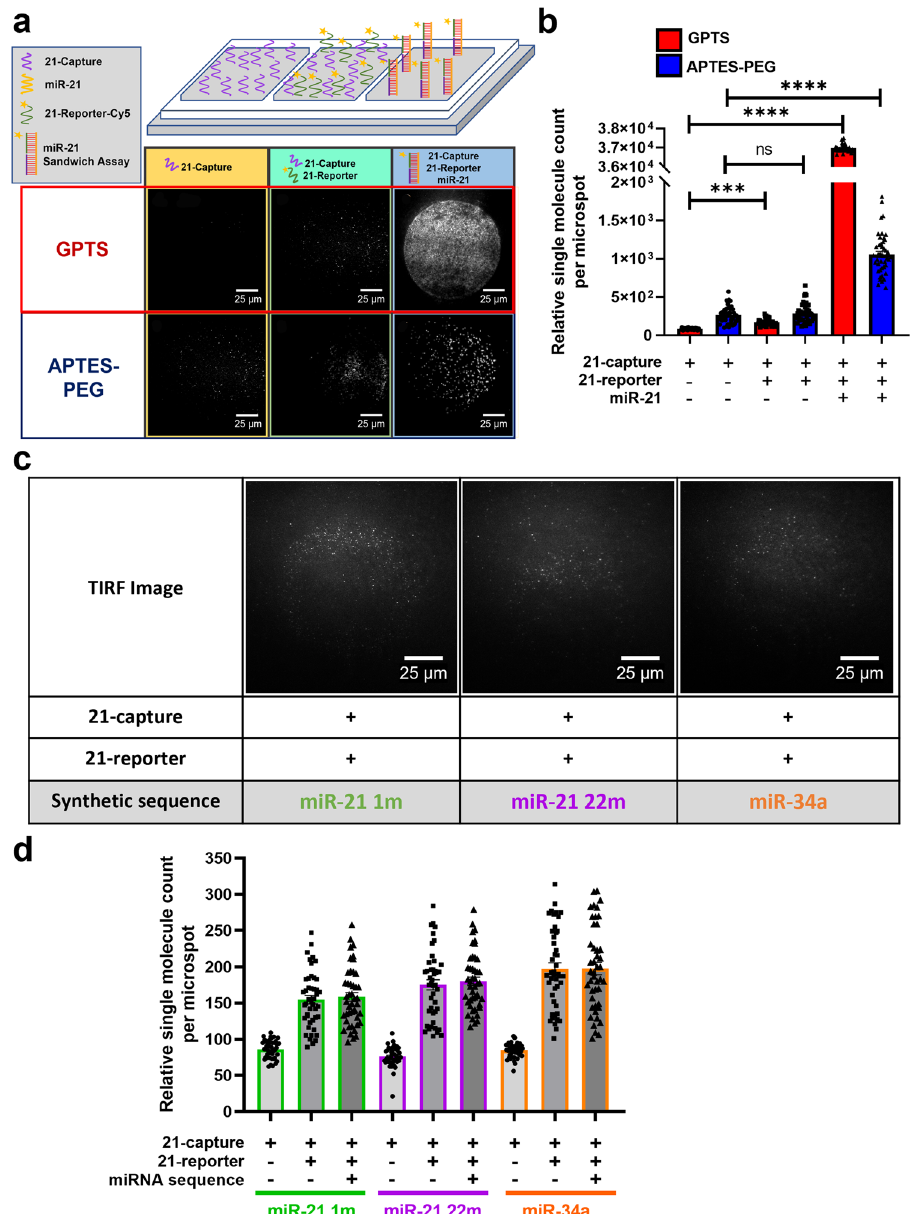
Fig. 1 MiR-21 assay development. a Schematic diagram of an open chip platform consisting of three wells comparing GPTS (Red) and APTES-PEG (Blue) passivated surfaces: fi rst well with 21-capture probe, second well with 21-capture and 21-reporter probes, and third well containing 1.2 ×10 6 molecules/nL miR-21 sequences with 21-capture and 21-reporter probes. TIRF images show single molecule binding events taking place on GPTS and APTES-PEG functionalised surface within the open chip. b Bar graph of single miR-21 molecules detected using the 21-capture microarrayed spots within the open chip. Open chips were incubated and imaged every 10 min for 2 h. Data are presented as individual points and mean ± SEM analysed by Kruskal-Wallis test with post hoc Dunns *** p < 0.001 and **** p < 0.0001. c Raw TIRF images of microarrayed spots showing negligible single molecule binding of 21-capture and 21- reporter with miR-21 single-base modi fi cation at position 1 (miR-21 1m), 22 (miR-21 22m) and miR-34a. d Bar graph of relative single molecule count detected on 21-capture microarrayed spots in an open chip device with miR-21 1 m (green), mir-21 22m (purple) and miR-34a (orange) sequences present in individual wells. Open chips were incubated and imaged every 10 min for 2 h. Data are presented as individual points and mean ±